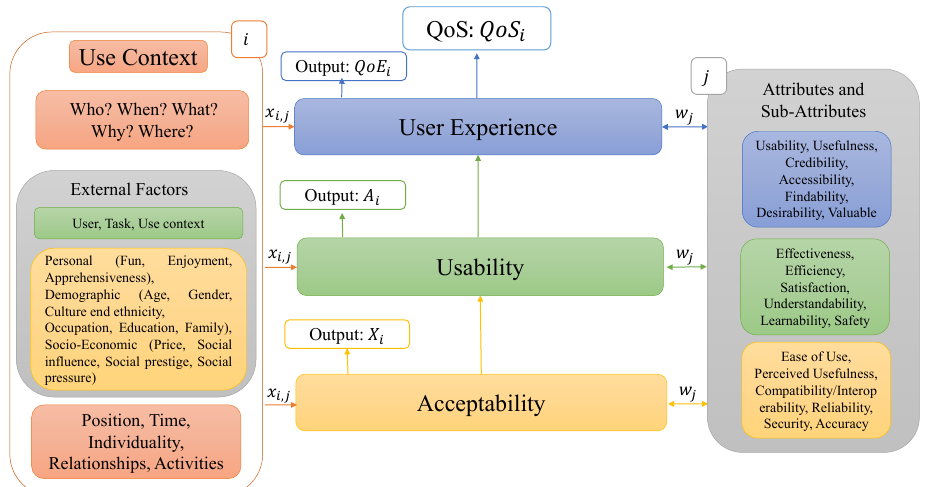
Figure 2. CoKnowEMe. The figure describes the architectural model for evaluation Qos of IoMT microservices and shows the modular structure, the concepts taken into account for the evaluation with their attributes and